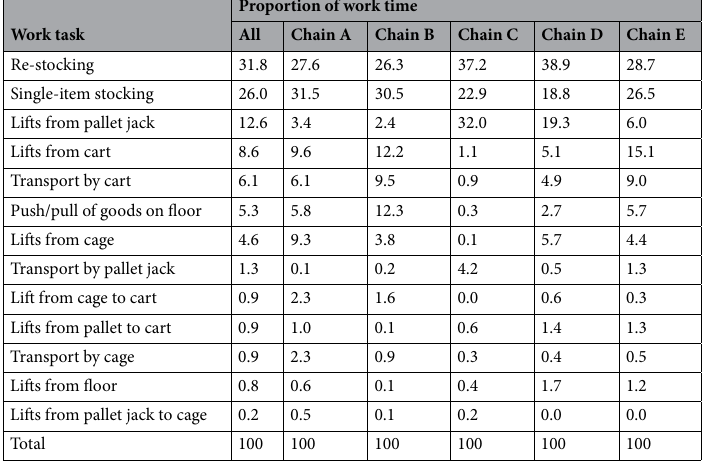
Table 4. Stocking practices. Proportion (%) of all observed work tasks.